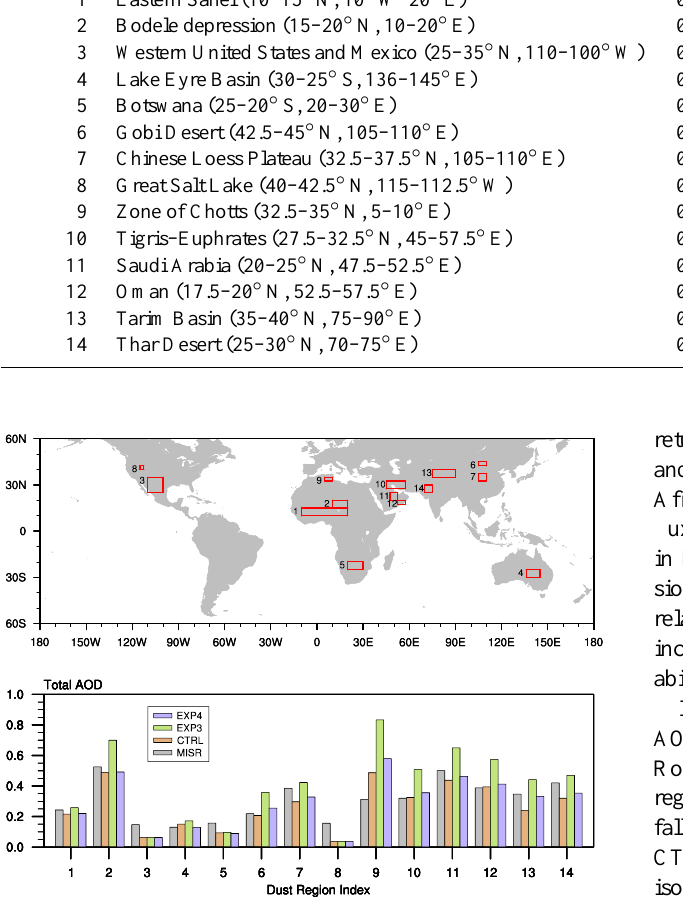
Figure17. SatelliteretrievedAODfromMISR(Multi-angleImagingSpectro-Radiometer)andsimulatedregionalaverageAODat550nm Figure 17. Satellite retrieved AOD from MISR (Multi-angle Imag- at14majordustsourceregions( Tgyr  1 )fortheyear2006.TheseregionsweredefinedintheworkofZenderandKwon(2005)basedon thedustsourceregionsidentifiedbyProsperoetal.(2002)anddatafromTorresetal.(2002).Regiondefinitionandthedatausedtoplotthe ing Spectro-Radiometer) and simulated regional average AOD at lowerpanelaregivenTable4. 550nm at 14 major dust source regions (Tgyr − 1 ) for the year 2006. These regions were defined in the work of Zender and Kwon (2005) Table4. Definitionofthe14majordustsourceregionsinwhichthesimulatedandMISRretrievedAODarecomparedinFig.17.Therelative differencesbetweenthesimulatedandMISRretrievedAODarealsoshown. based on the dust source regions identified by Prospero et al. (2002) and data from Torres et al. (2002). Region definition and the data used to plot the lower panel are given Table